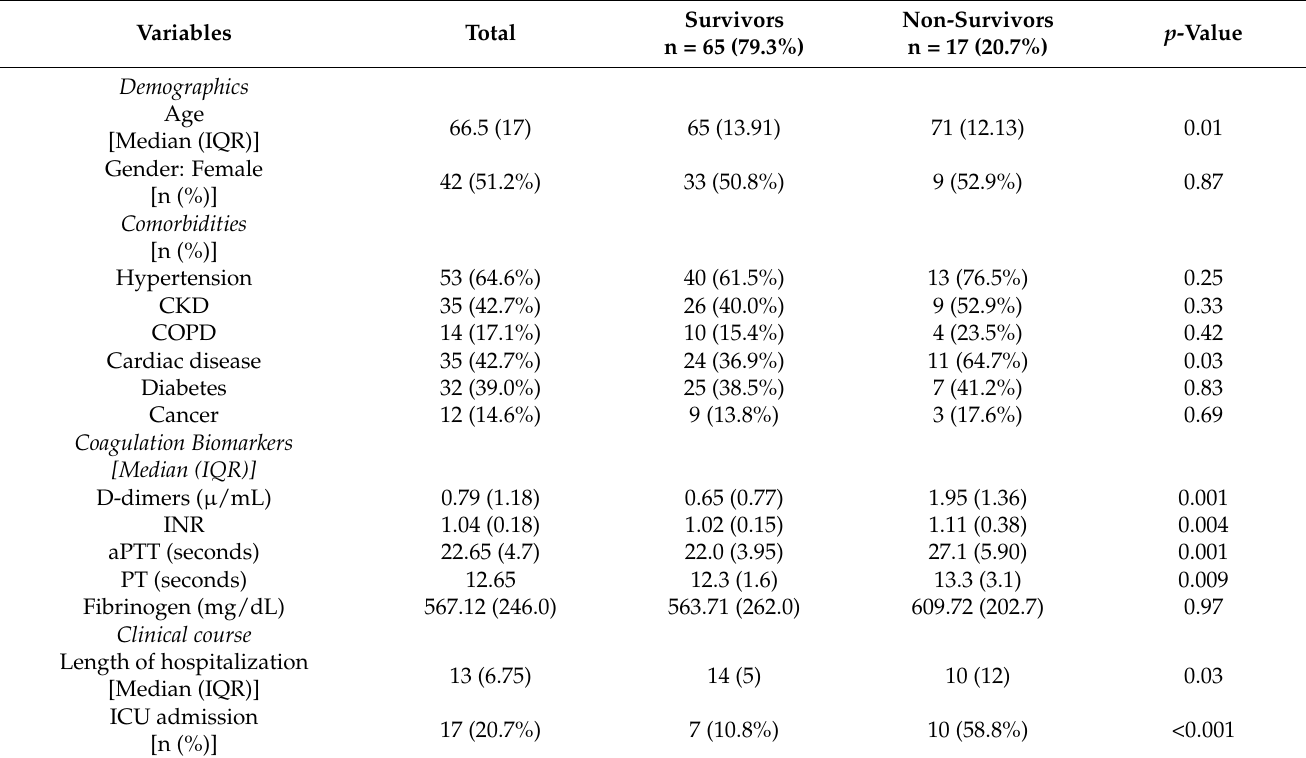
Table 1. C haracteristics of 82 COVID-19 participants. Table 1. Characteristics of 82 COVID-19